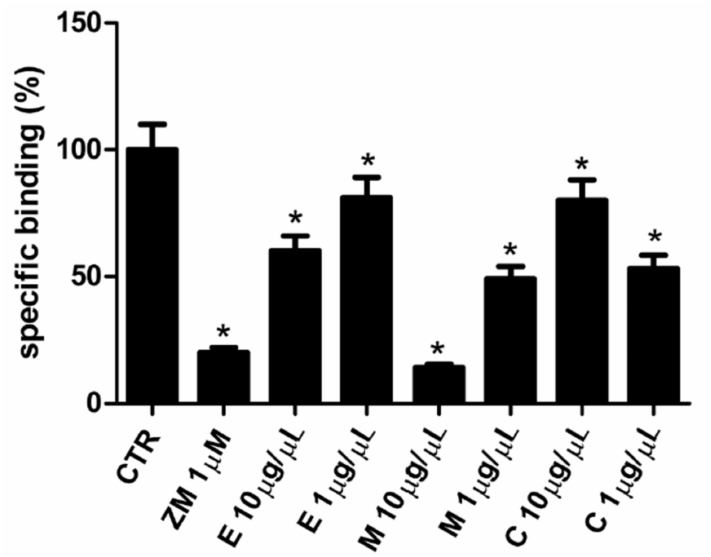
Figure 3. A 2A receptor binding by 40% ethanol plant extracts. Radioligand competition binding assay to human A 2A adenosine receptor transfected in CHO cells. Effect of 1 µ M A 2A receptor antag- onist ZM 241385, 1 µ g/ µ L and 0.1 µ g/ µ L Epilobium parviflorum , Melilotus officinalis , Cardiospermum halicacabum ethanol plant extracts on [ 3 H]ZM 241385 specific binding. Bars represent % mean ± SEM. * p < 0.05 vs. control